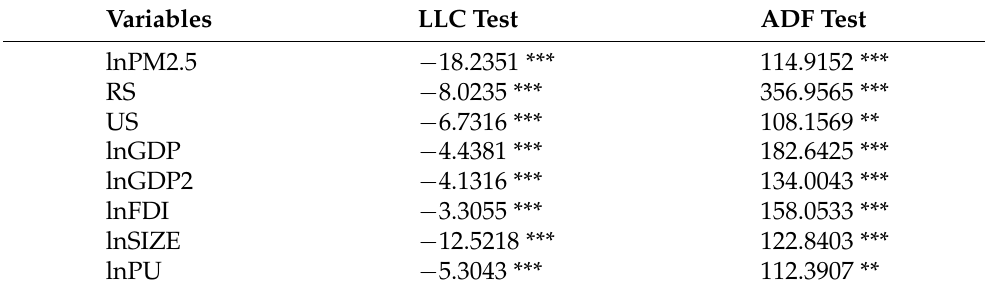
Table 4. Unit root